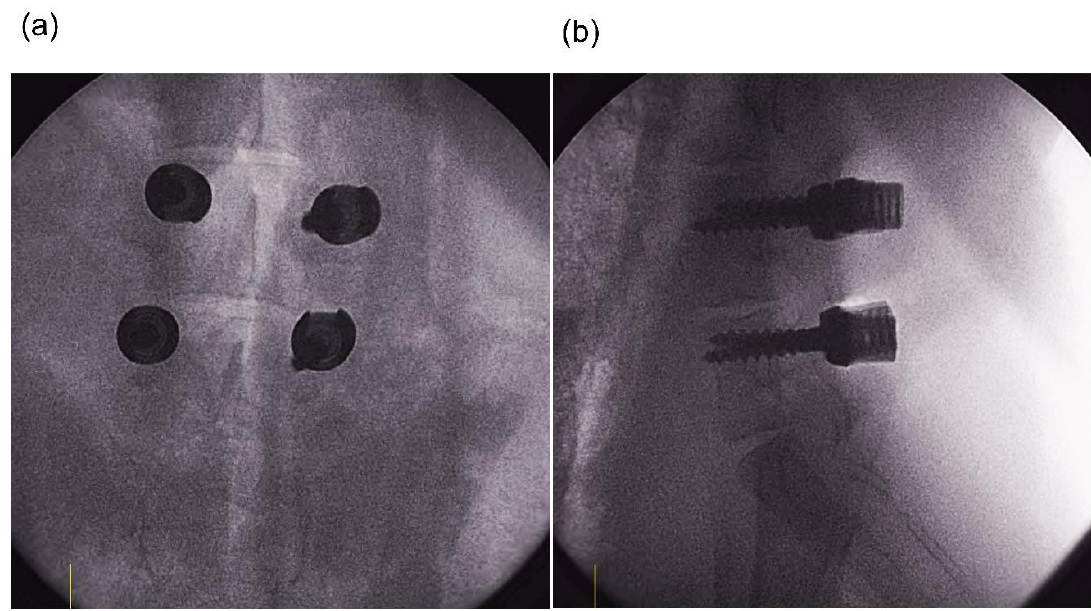
Figure 4. Intraoperative fluoroscopy. ( a ) Posteroanterior view. ( b ) Lateral view.